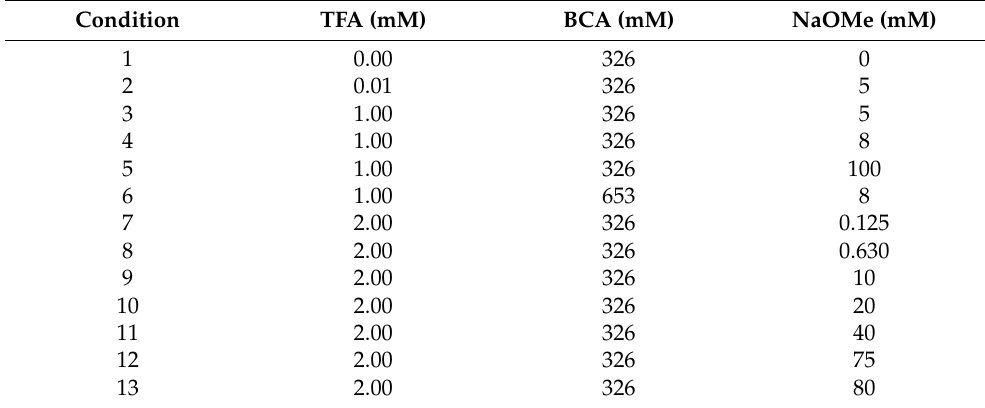
Table 1. Conditions during anionic polymerization in